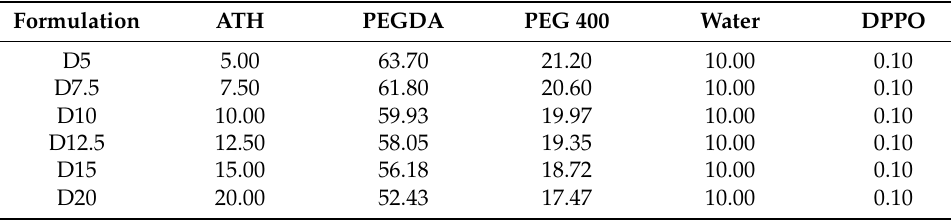
Table 3. Compositions ( w / w ) of photoreactive mixtures used for 3D printing.